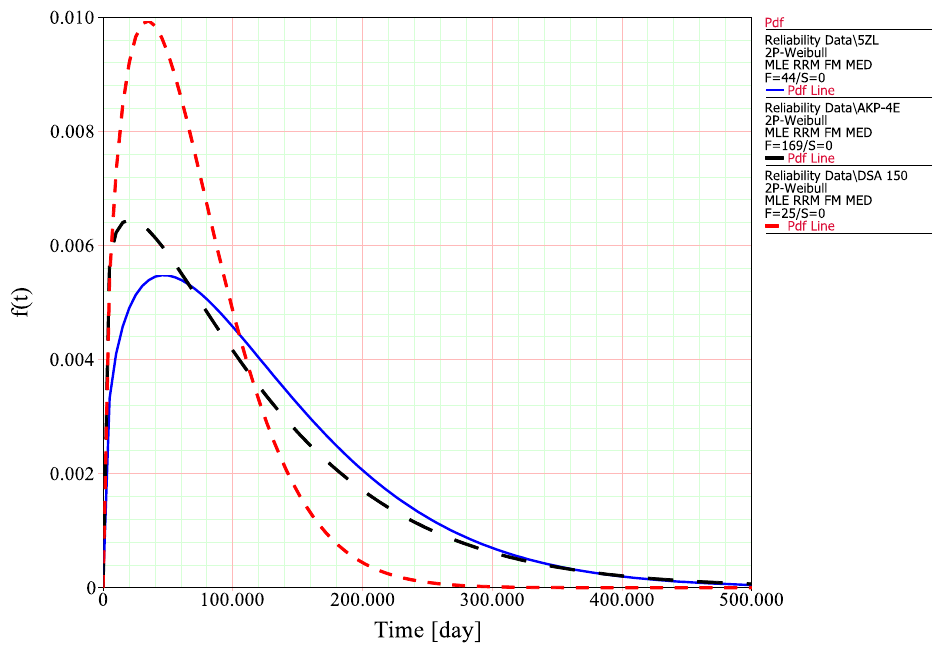
Figure 7. Probability density function for the selected types of pantograph: ( a ) DSA-150 (red); ( b ) AKP-4E (black); and ( c ) 5-ZL (blue). Table 4. Calculated MTTF and t f = max parameters for the selected types of pantographs.